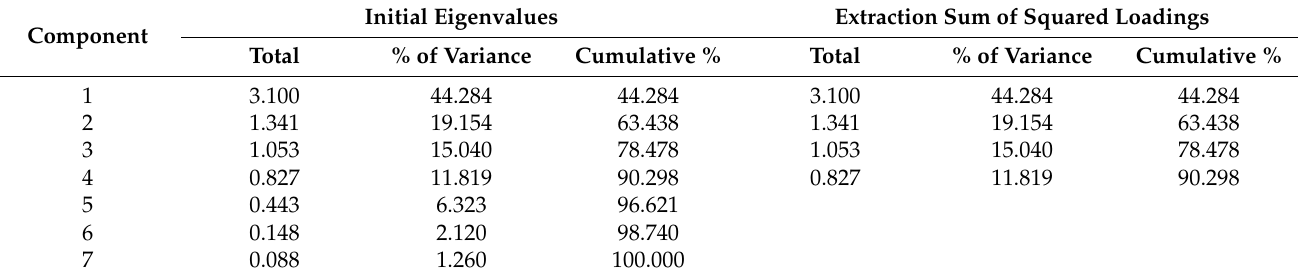
Table 5. Total variance explained.